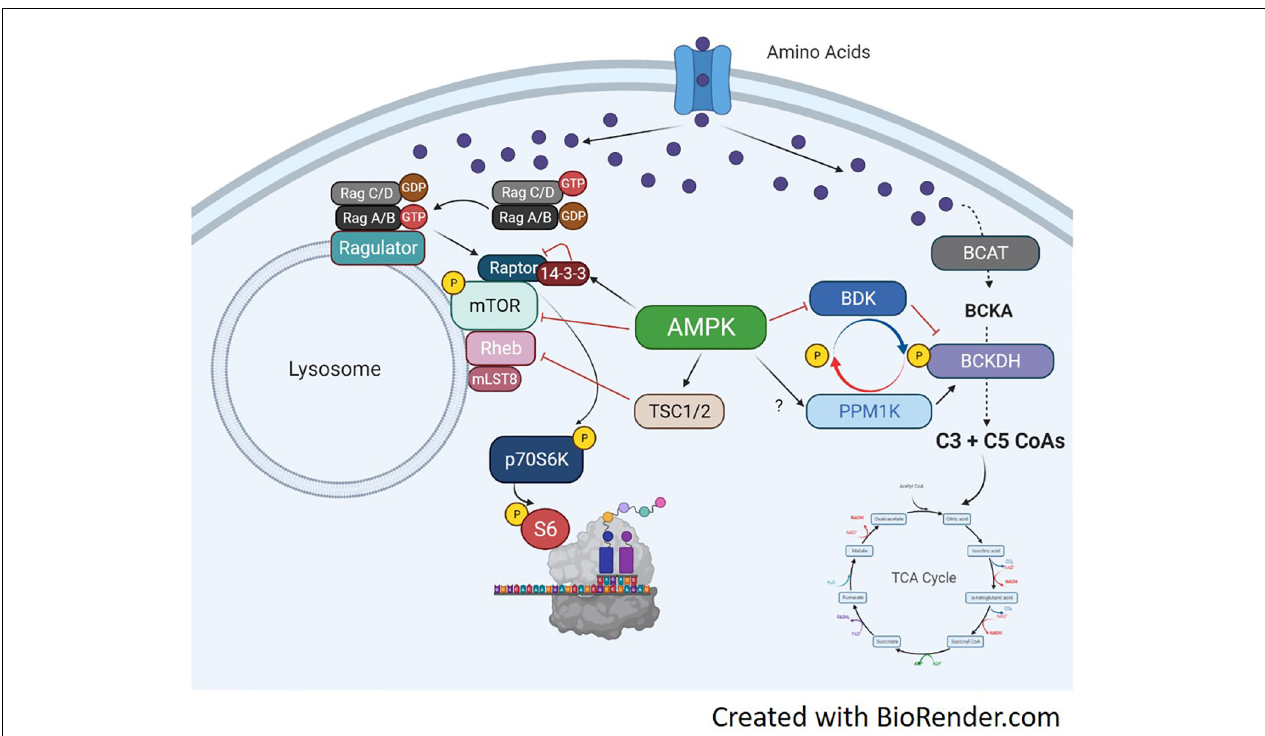
FIGURE 4 | Molecular mechanisms of amino acid trafficking. Amino acids, especially BCAAs, enter the cell via their respective transporters. Once in the cell, depending on metabolic need, they can be metabolized for energy or used for other biochemical processes like protein synthesis. If needed for energy, the enzyme BCAT metabolizes the BCAA into branched-chain keto acids, which undergo a series of catabolic reactions to produce C3 and C5 CoAs by BCKDH. The C3/5 CoAs are then converted to either acetyl CoA or Succinyl CoA and can enter the TCA cycle. BCKDH is regulated by phosphorylation/dephosphorylation by the kinase BDK and the phosphatase PPM1K, respectively. Phosphorylation of BCKDH by BDK inhibits BCKDH activity while dephosphorylation by PPM1K activates BCKDH and increases generation of BCAA-derived CoAs for energy production. The activation of the BCAT/BCKDH pathway pulls amino acids away from the associated mTORC1 complexes and inhibits protein synthesis. If BDK is able to phosphorylate BCKDH, or PPM1K is inhibited, amino acids would be available to active mTORC1 and initiate protein translation. AMPK can regulate BCAA metabolism by increasing PPM1K and lowering BDK expression, which will activate BCKDH and increase BCAA flux to the TCA cycle. AMPK can simultaneously block mTORC1 signaling through activation of TSC1/2 or direct inhibition of mTOR and